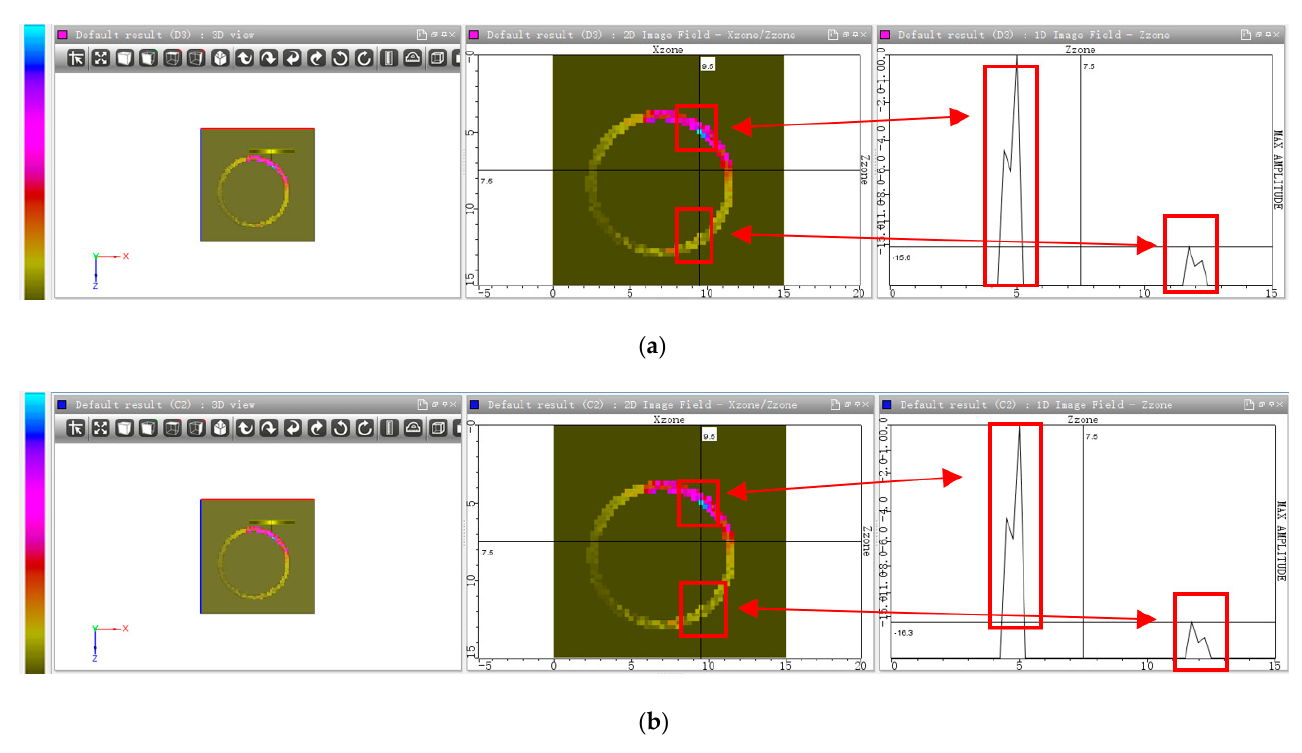
Figure 8. ( a ) The sound field with normal fuel rod; ( b ) the sound field with failed fuel rod.